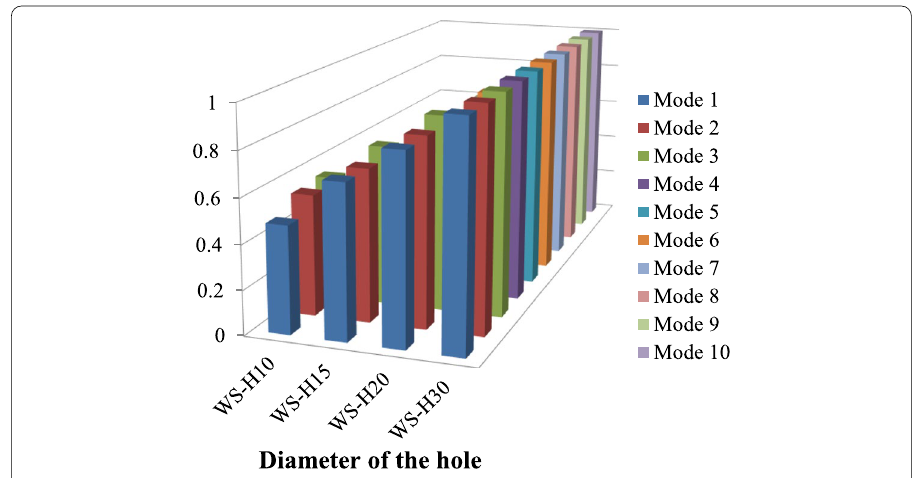
Fig. 23 Comparison of frequencies for the plates without stiffener but with